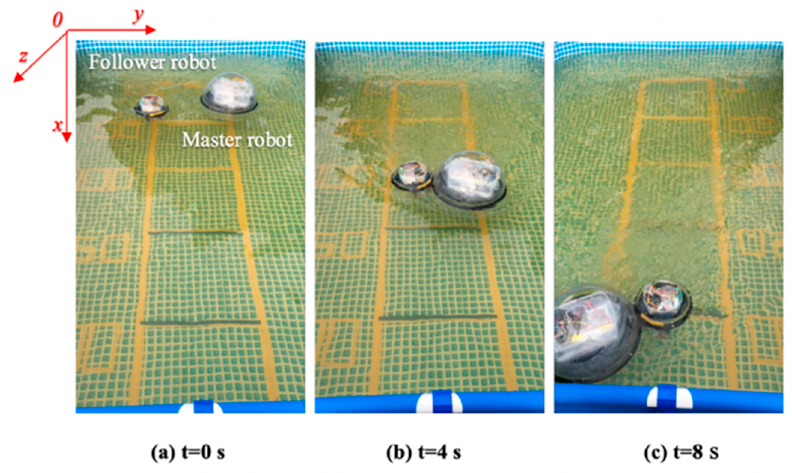
Figure 31. Following images based on the visual servoing algorithm.